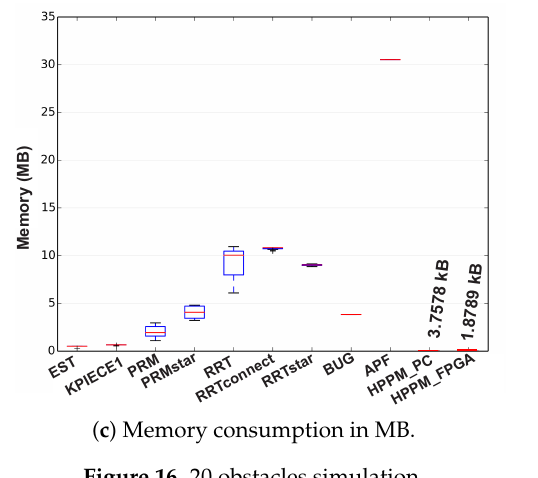
Figure 16. 20 obstacles simulation.